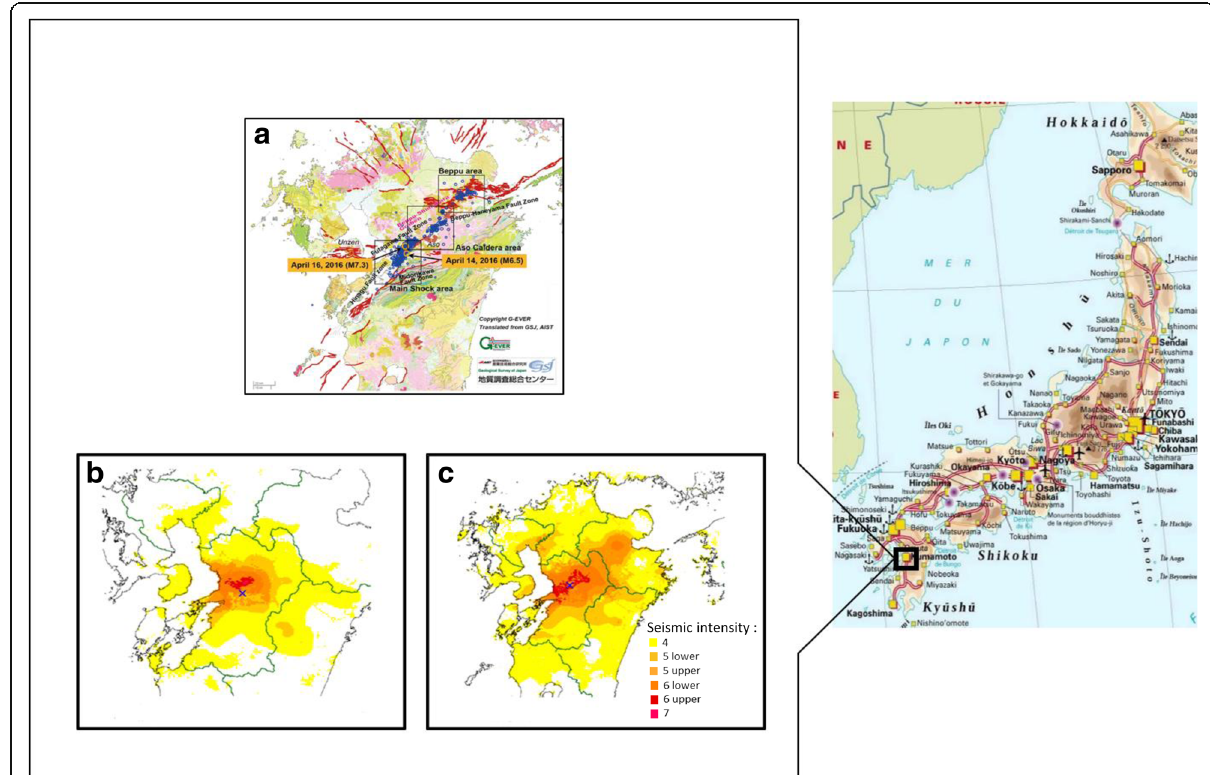
Fig. 1 a Epicenters distribution map; b Foreshock estimated seismic intensity distribution map; c Mainshock estimated seismic intensity distribution